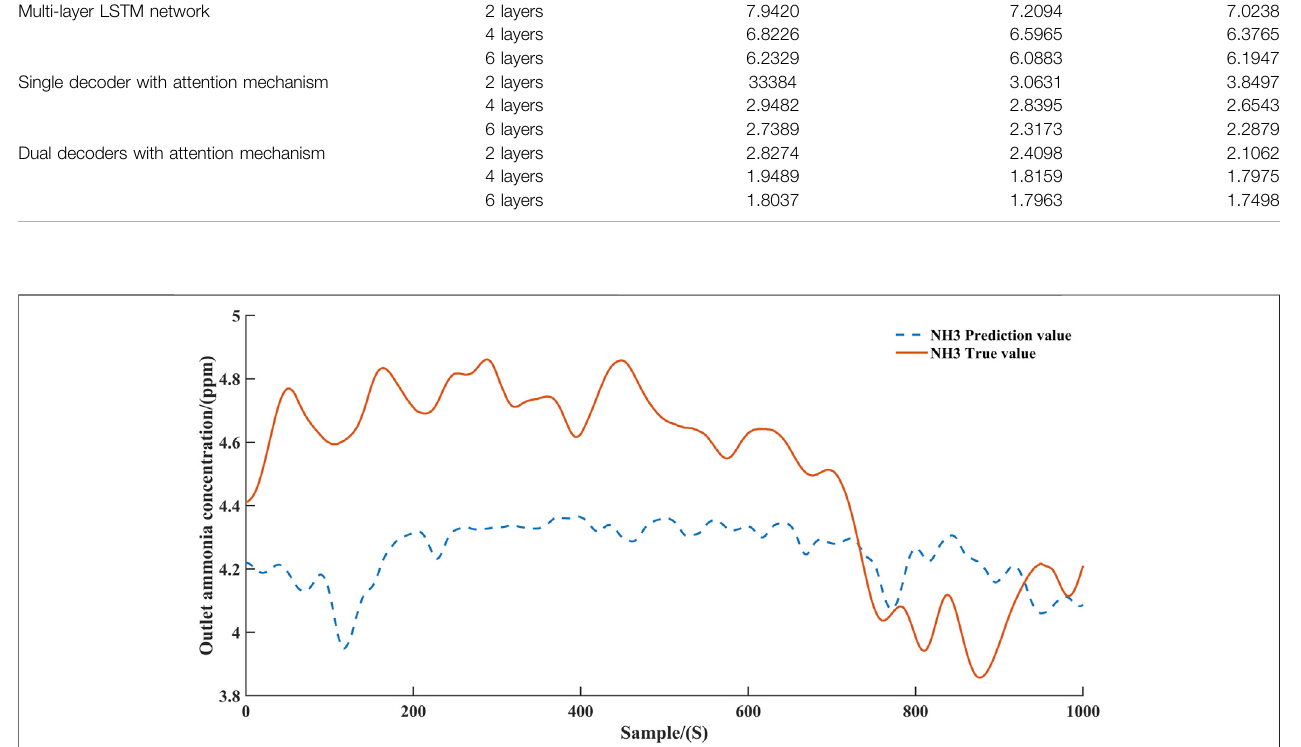
FIGURE 4 | Ammonia concentration prediction